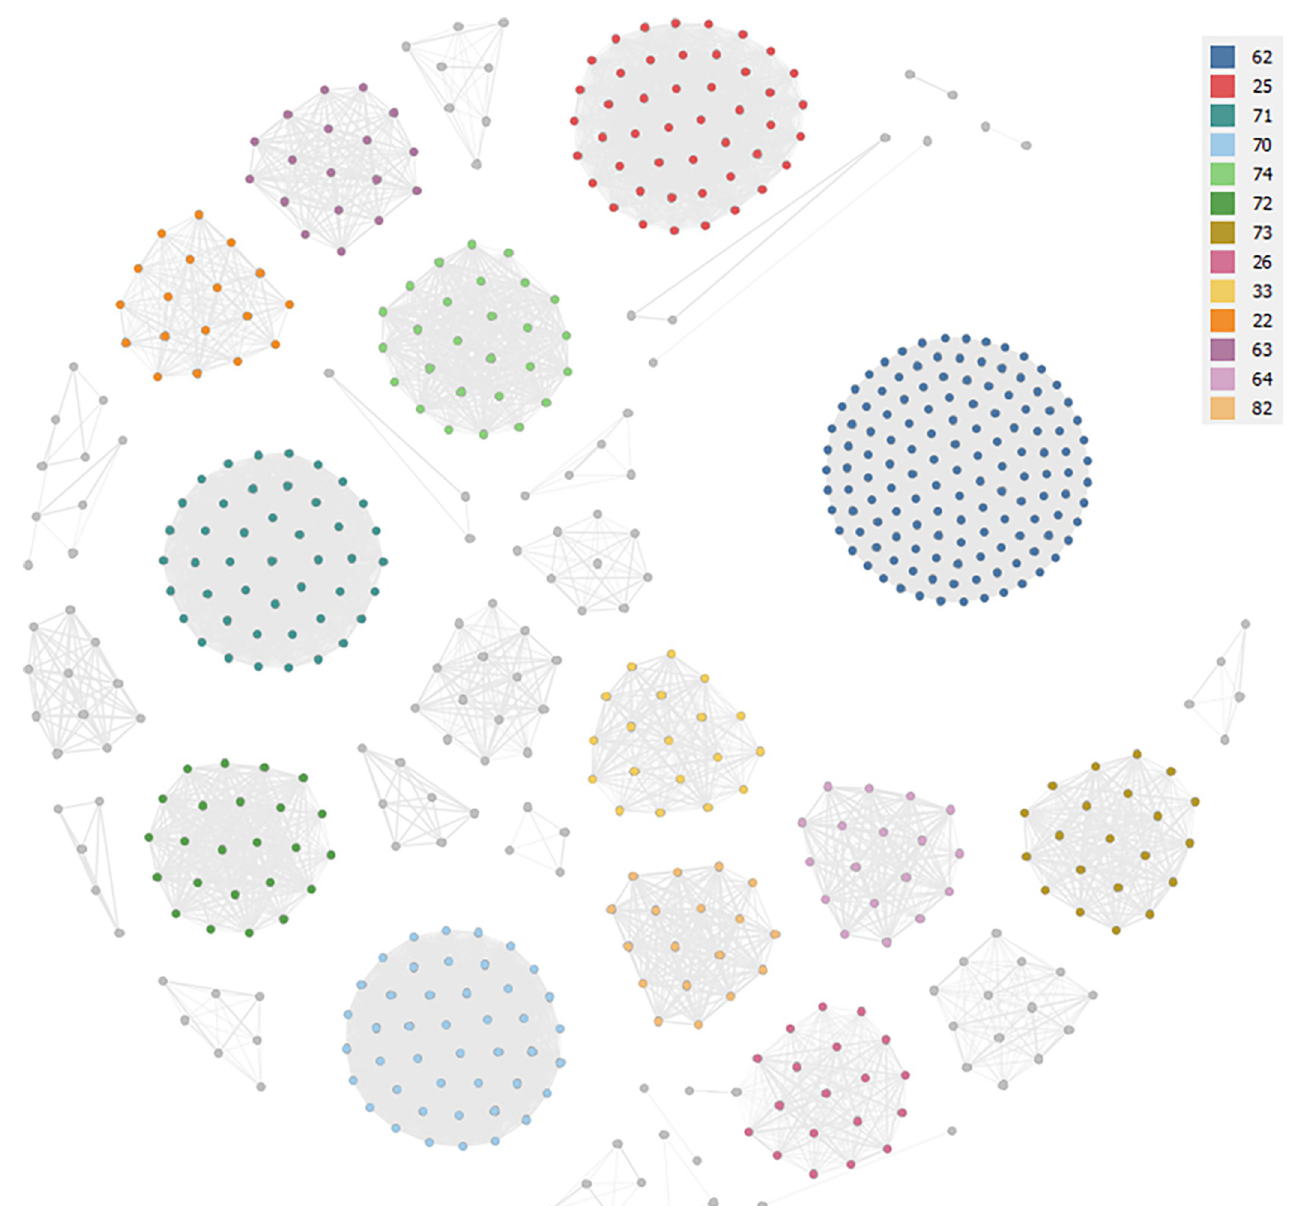
Fig 2. The network of firms based on Ateco 2007. Labels on larger (above 3% frequency) clusters of nodes indicate firms’ Ateco 2007 2-digit class. 48.69, which would seem to indicate a rather high level of interaction between the nodes of the network but which, on closer examination, can be explained by the high level of interconnec- tion between the nodes belonging to the software sector: 133 firms sharing the 5-digit class within economic activity ‘62 –Software’. Based on the value of the graph density (the ratio of the number of edges and the number of possible edges), it results in a rather limited level of interconnection, with a 0.09. High, as we can appreciate from the visualization, the level of dis- persion of the network, with modularity (the measure of the strength of division of a network into groups or clusters; networks with high modularity have dense connections between the